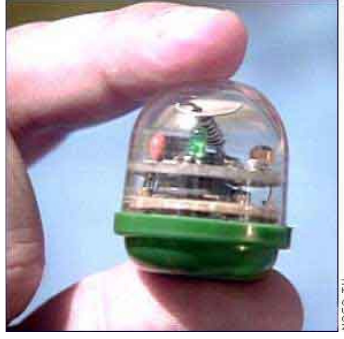
Figure 4. Sensor Web 1